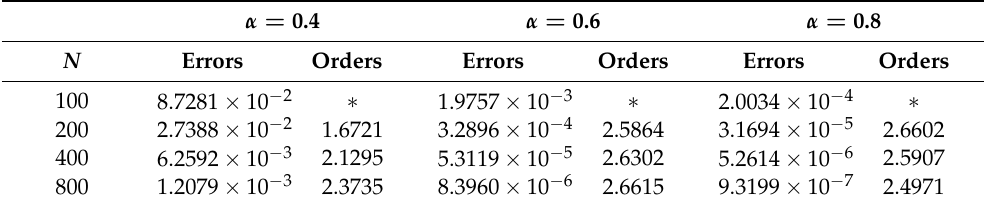
Table 5. Errors and orders in temporal direction for Scheme V (Example